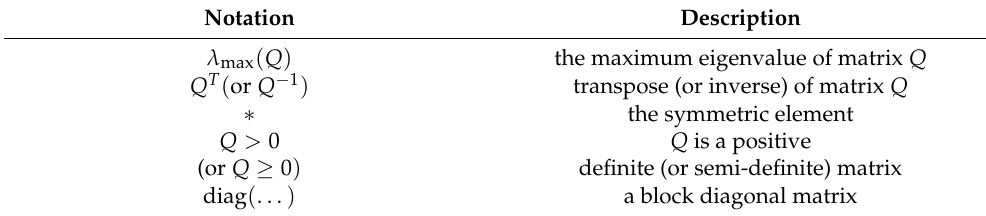
Table 1. Notations and